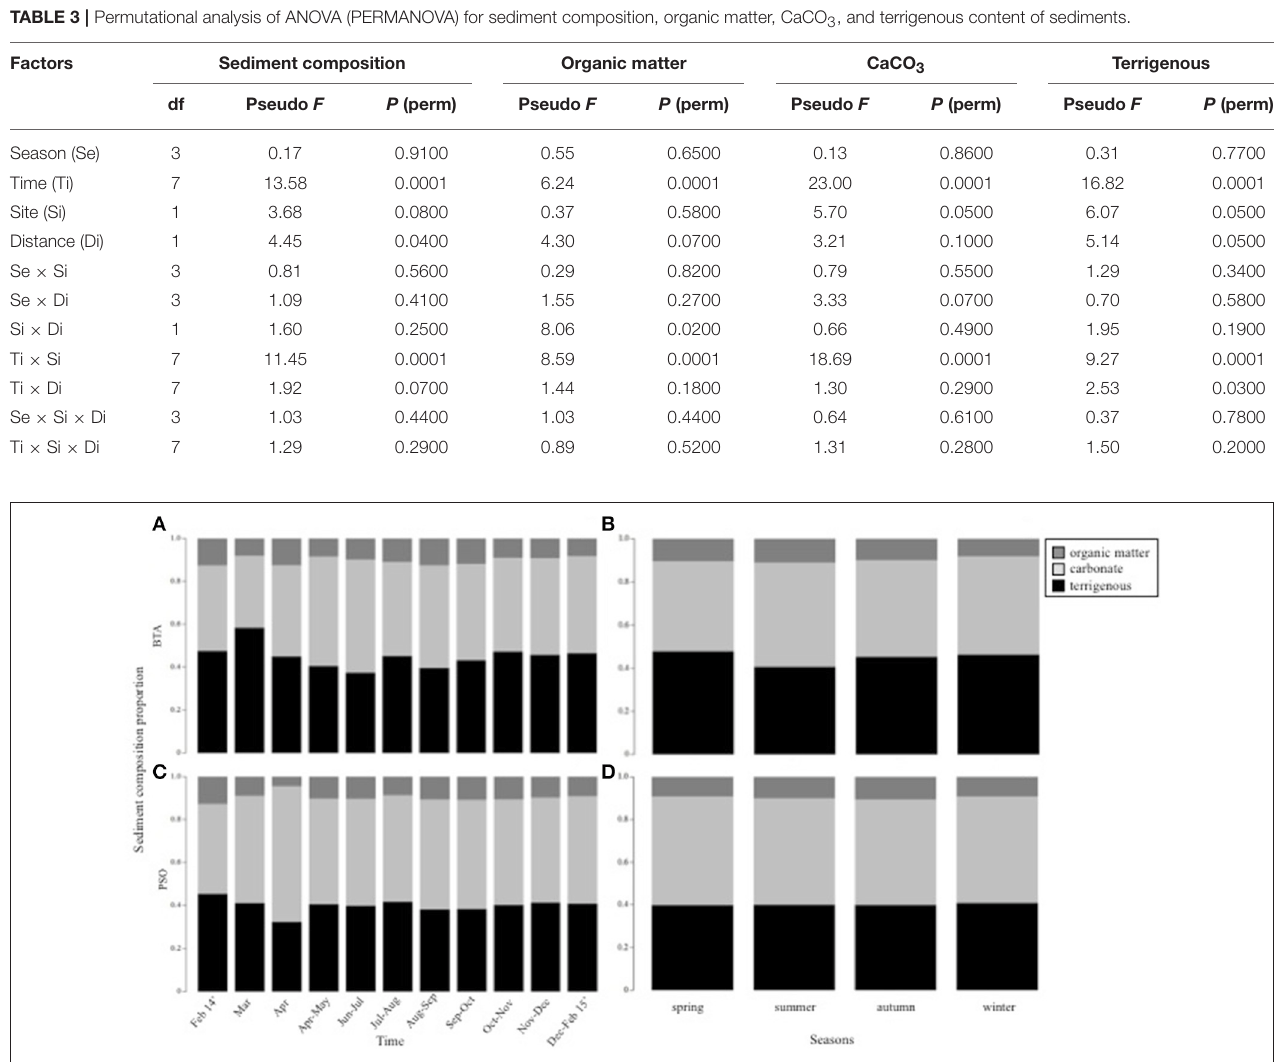
FIGURE 8 | Patterns of variation in sediment composition proportion by time (A) and seasons (B) at BTA, and PSO (C,D) . Dark gray stacked bar: percent organic matter, light gray: percent CaCO 3 , and black: percent terrigenous.